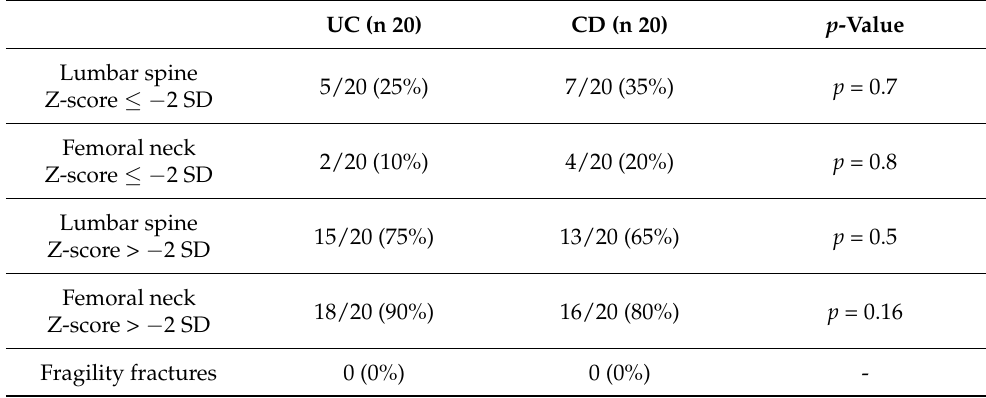
Table 5. Distribution of BMD Z-value alterations among patients with UC and CD of group 1.